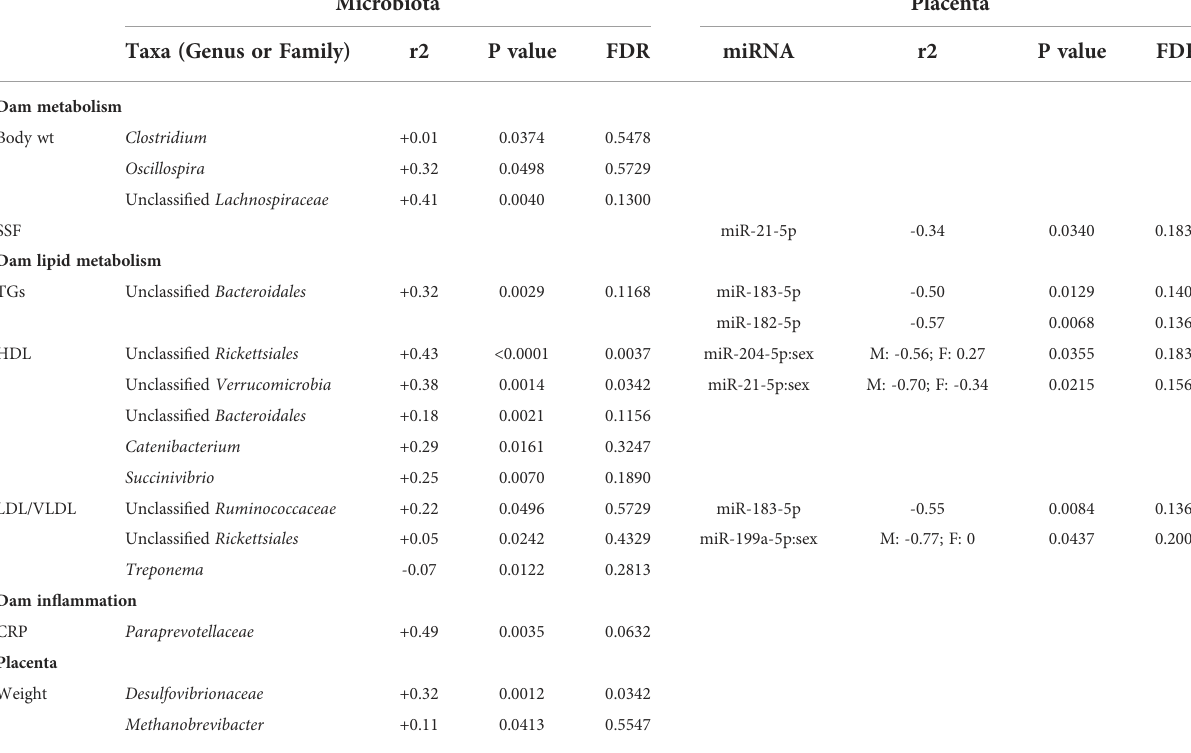
TABLE 1 Associations of maternal metabolic measurements compared to maternal microbiota and placental miRNA.